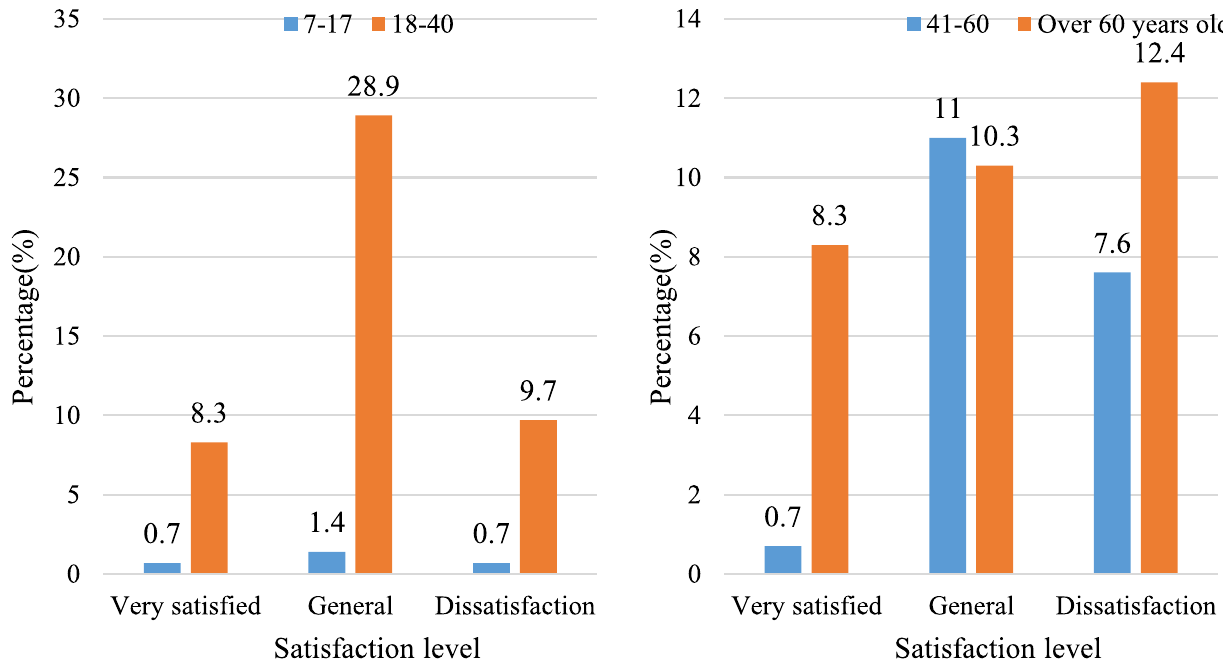
Fig. 6 Satisfaction of different age groups with existing local activity